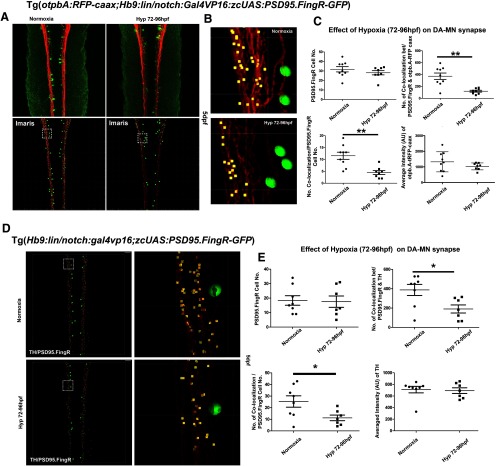
Hypoxia causes a decrease in DDT/motor neuron synapses. A, Confocal images of spinal cord of Tg(otpb.A.:TRFP-caax); Tg(Hb9:FingR(PSD95)-GFP) larvae, anti-GFP, anti-RFP labeling. Rostral to top, DDT labeled in red, motor neurons in green, synapses in yellow. B, Magnified view of IMARIS imaging of synapses. C, Quantification, mean and SD, **p < 0.01. Number of motor neurons and intensity of DDT is not affected by hypoxia, but number of synapses is decreased, including when corrected for motor neuron number. D, Confocal images of spinal cord of Tg(Hb9:FingR(PSD95)-GFP) larvae with anti-TH anti-GFP immunohistochemistry. Right panels, IMARIS panel image shown to right of corresponding confocal image. E, Quantification with mean and SD shows that number of motor neurons and intensity of DDT is not affected by hypoxia, but number of synapses is decreased, including when corrected for motor neuron number. *p < 0.05.